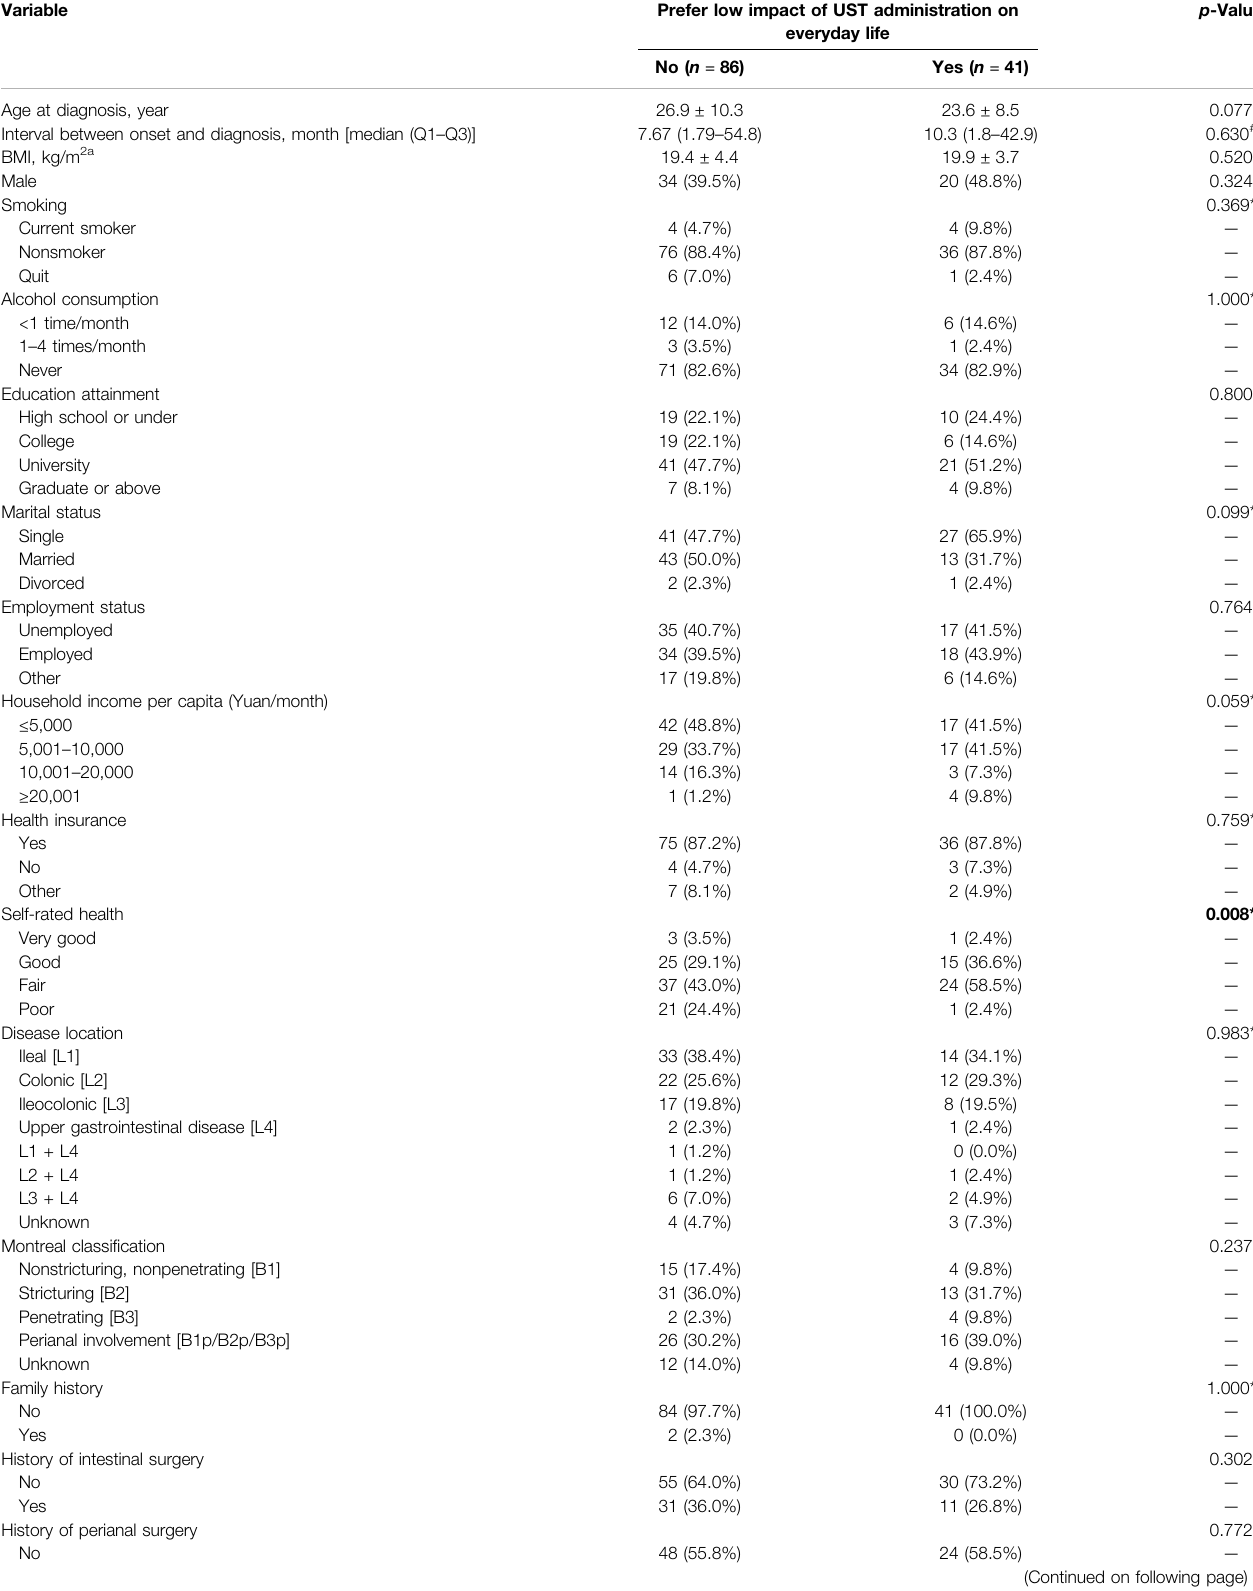
TABLE 8 | Characteristics of participants with different preference toward impact of UST administration on everyday life.